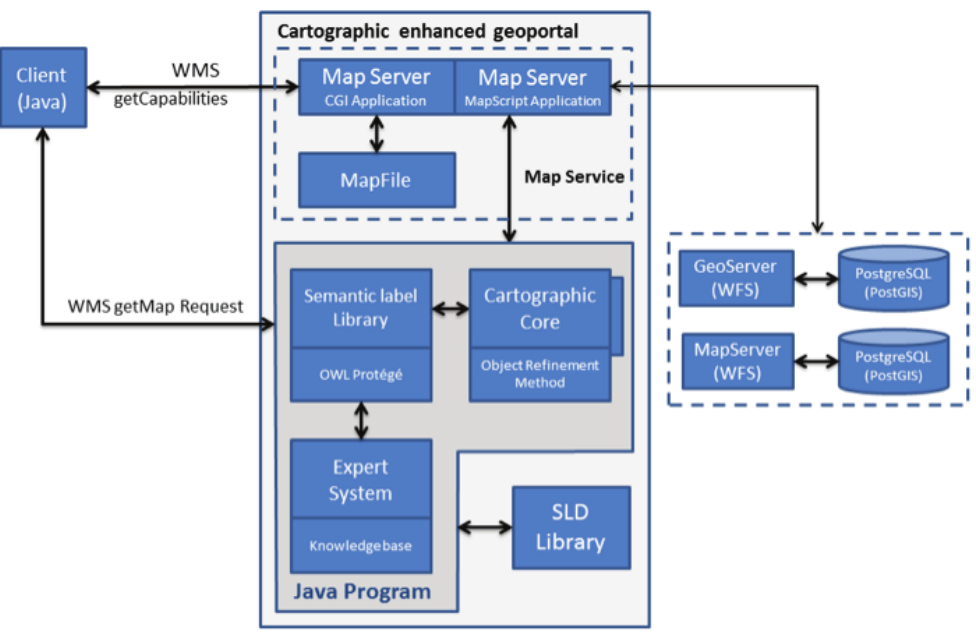
Figure 6: Implementation of the components used in the